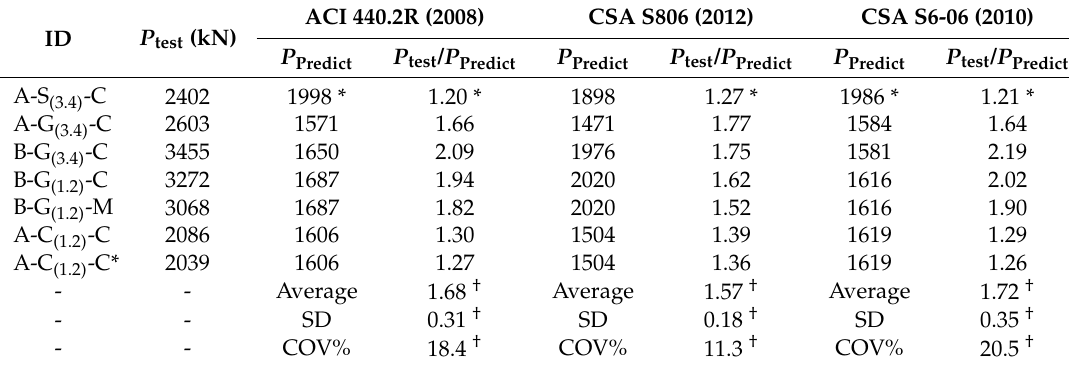
Table 6. Code predications comparisons versus test results for CFFT-reinforced columns (consideration of allowable confinement codes limits).